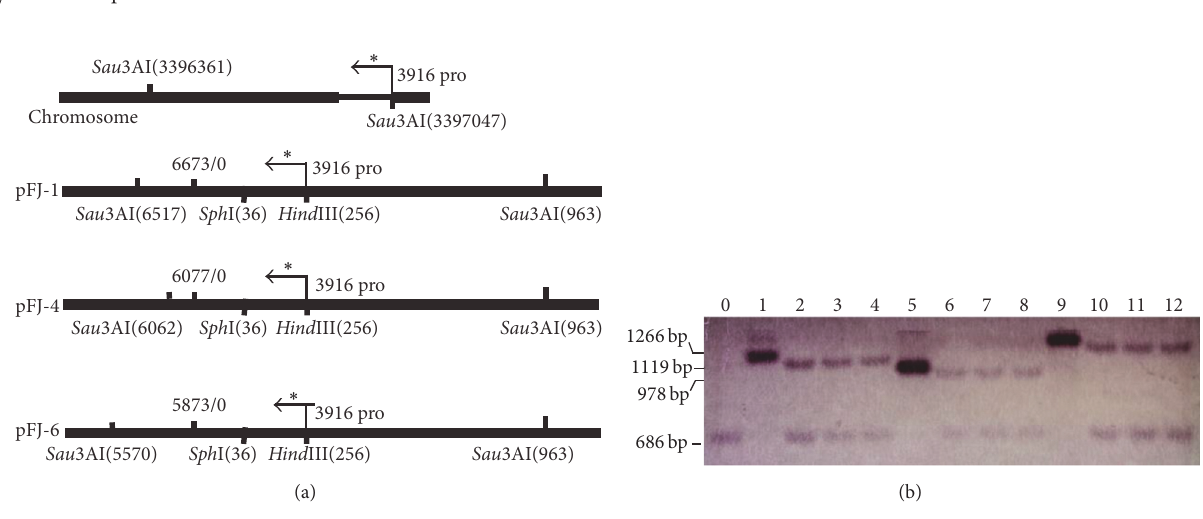
Figure 4: Determination of whether pFJ1, pFJ4, and pFJ6 could integrate into the J7 chromosome by Southern blot analysis. Hin dIII-digested total DNA extracted from cultures of J7-F clones carrying the pFJ1 (lanes 2–4), pFJ4 (lanes 6–8), or pFJ6 (lanes 10–12) plasmid were (a) separated on a 1% agarose gel at 20 V for > 12h and then (b) subjected to Southern blot analysis. The pFJ1, pFJ4, and pFJ6 plasmids were propagated in E. coli , digested with Hin dIII, and loaded on lanes 1, 5, and 9 as controls. The DIG-labeled pyr F sequence was used as a hybridization probe.